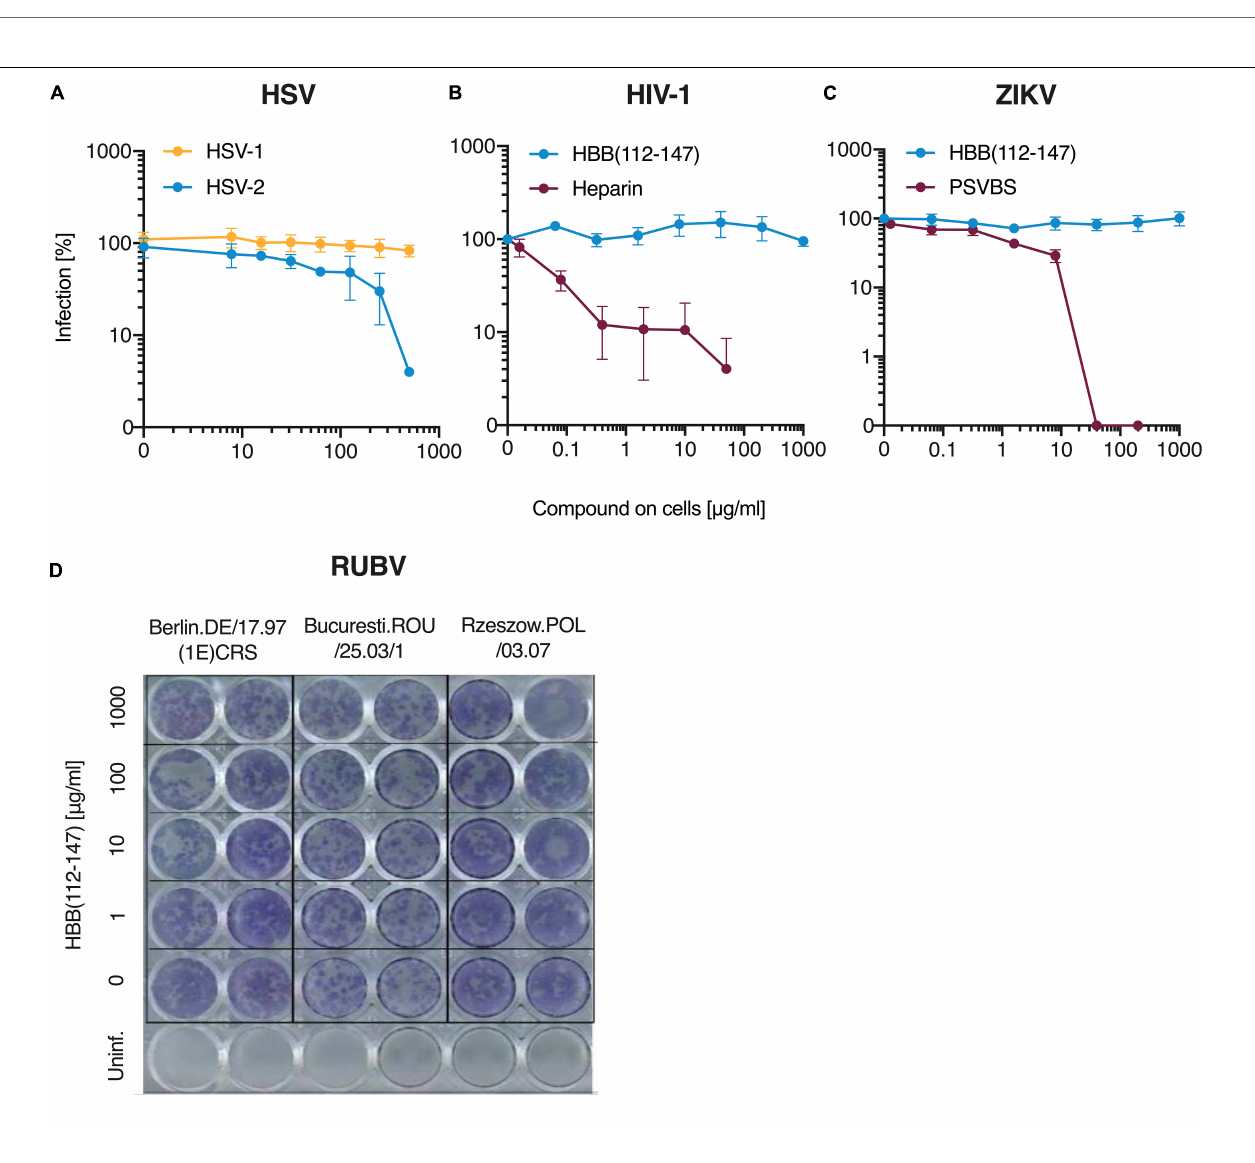
FIGURE 3 | Antiviral activity of HBB(112–147) against HSV-1, HIV-1, ZIKV and RUBV. (A) Peptide was added to ELVIS cells and cells then infected with one clinical HSV-1 isolates and a second isolate of HSV-2. Infection rates were determined two days later by quantifying β -galactosidase activities. (B) TZM-bl reporter cells were incubated with HBB(112–147) or the polyanion Heparin and then infected with HIV-1. Three days post-infection, infection was determined by measuring β -galactosidase activities in cellular lysates. (C) Vero E6 cells were supplement with HBB(112–147) or the macromolecular compound PSVBS and infected with ZIKV-MR766. Two days later, infection was quantified by an in cell ELISA that detected the viral E protein. Values shown in (A–C) are mean values derived from triplicate experiments. (D) Three rubella virus isolates were exposed to indicated concentrations of HBB(112–147) and then inoculated onto Vero cells. Cells were treated with CMC-Overlay and incubated at 37 ◦ C. Five days later, RUBV infection was quantified by an indirect immunocolorimetric assay using the monoclonal anti-Rubella-E1(MAB 925) and photos taken by a digital